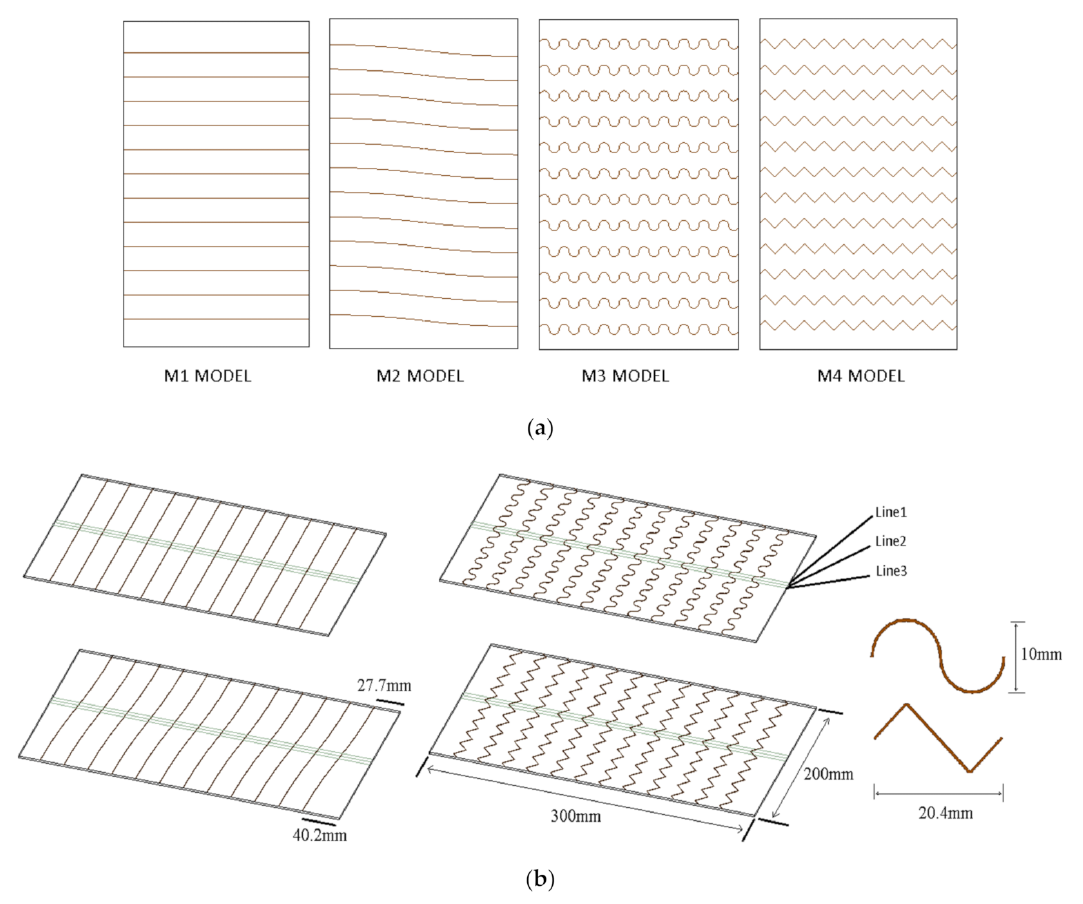
Figure 2. Electrode array models: ( a ) two-dimensional view of models; ( b ) view of models.